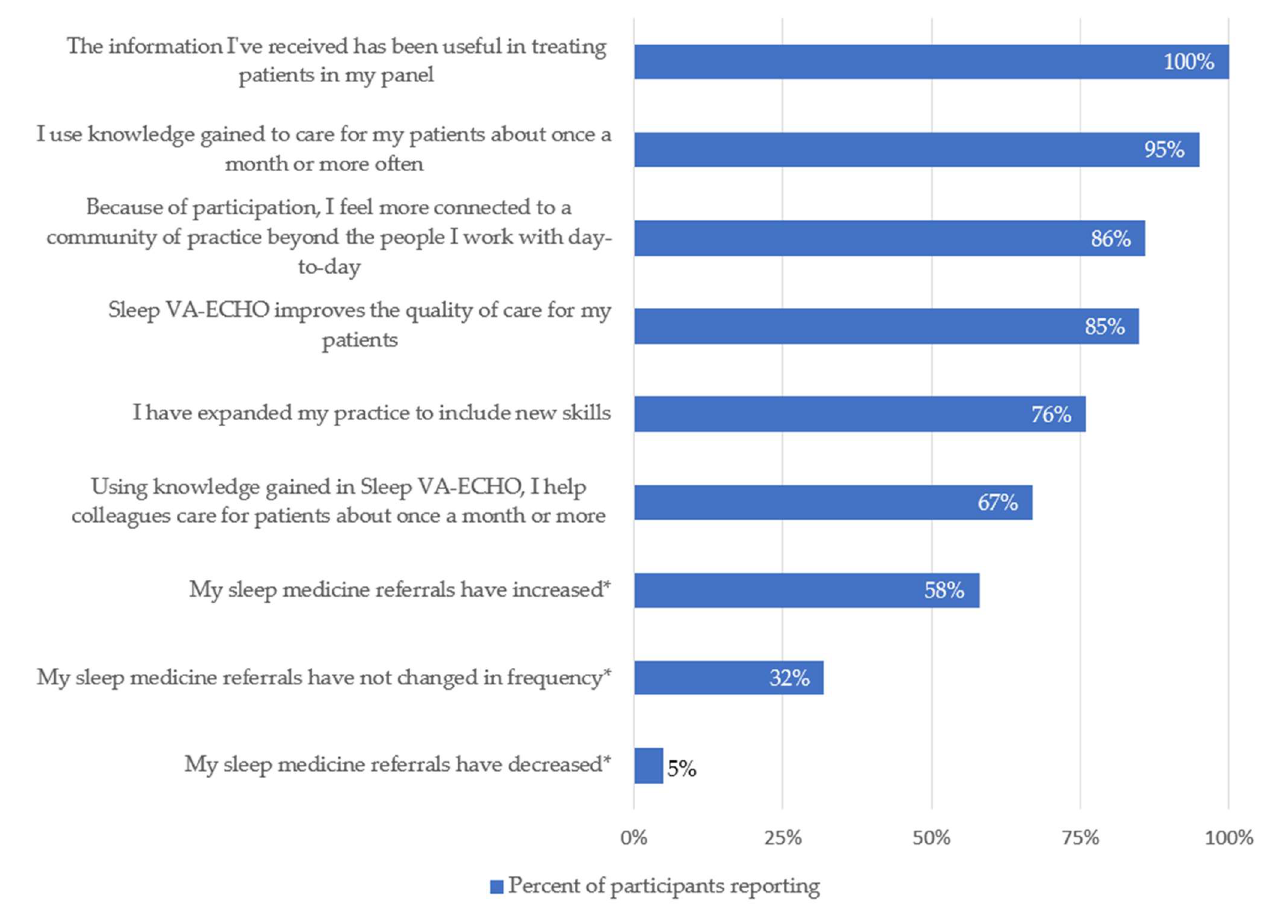
Figure 3. Specific ways participants report using knowledge gained. Abbreviations: VA-ECHO: Veterans Affairs–Extension for Community Healthcare Outcomes; * mutually exclusive options.